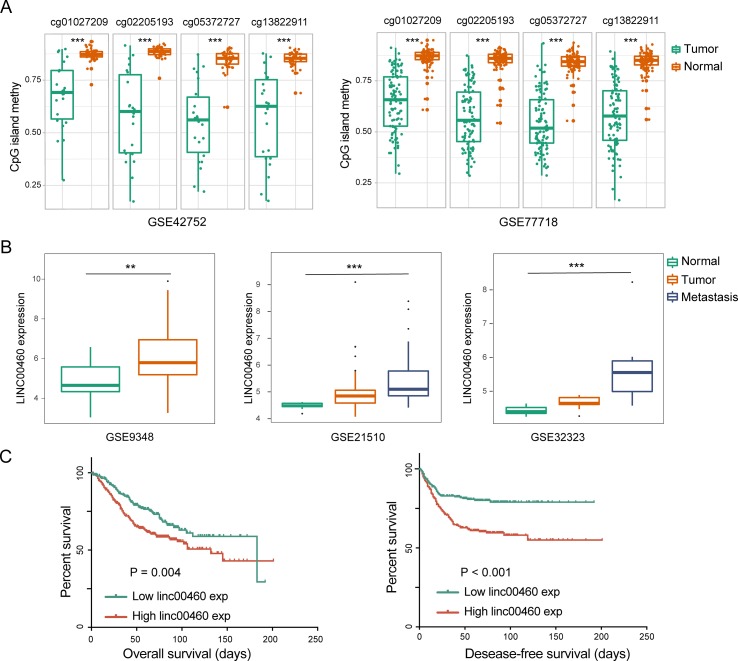
LINC00460 was correlated with metastasis and poor survival in CRC. (A) Abnormal methylation of four CpG islands between tumor and normal tissue in GSE42752 and GSE77718. (B) LINC00460 expression in GSE9348, GSE21510, and GSE32323. CRC patients with distant metastasis and a high expression of LINC00460. (C) Association between LINC00460 expression and CRC survival [overall survival (OS) and disease-free survival (DFS)] in GSE14333. **p < 0.01, ***p < 0.001.